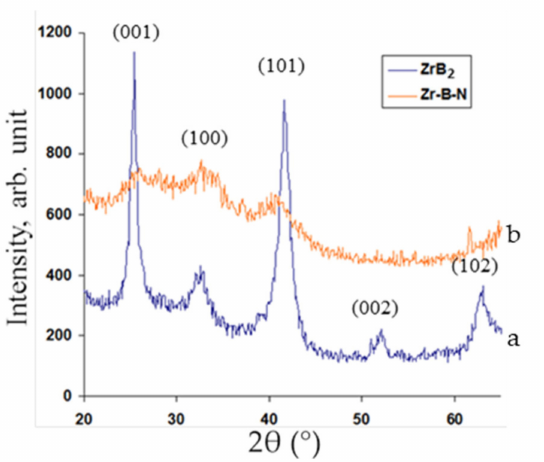
Figure 3. XRD patterns of coatings 1 (100%Ar) ( a ) and 2 (85%Ar + 15%N 2 ) ( b ). This phase is characterized by a pronounced texture in (001) direction, which coincides with the coating’s growth direction. Mean crystallite size was calculated using half-width of (001), (100) and (101) lines and was equal to 6–11 nm. The introduction of nitrogen decreased the size of h-ZrB 2 crystallites to 1–2 nm and changed the preferential orientation to (100). Similar trends were observed previously for the coatings based on borides of Cr and Ti [13]. The lattice spacings calculated using the three most intense lines on XRD patterns for the coatings deposited in Ar were 0.359, 0.292 and 0.232 nm. It should be noted that according to the reference data, the spacings for h-ZrB 2 are 0.353, 0.274, 0.216 nm. Therefore, we report results that are close or slightly higher as compared to the reference, which might be related to the introduction of excess boron atoms into the interstitial positions of the ZrB 2 lattice [48]. Additionally, internal stresses in the coatings can